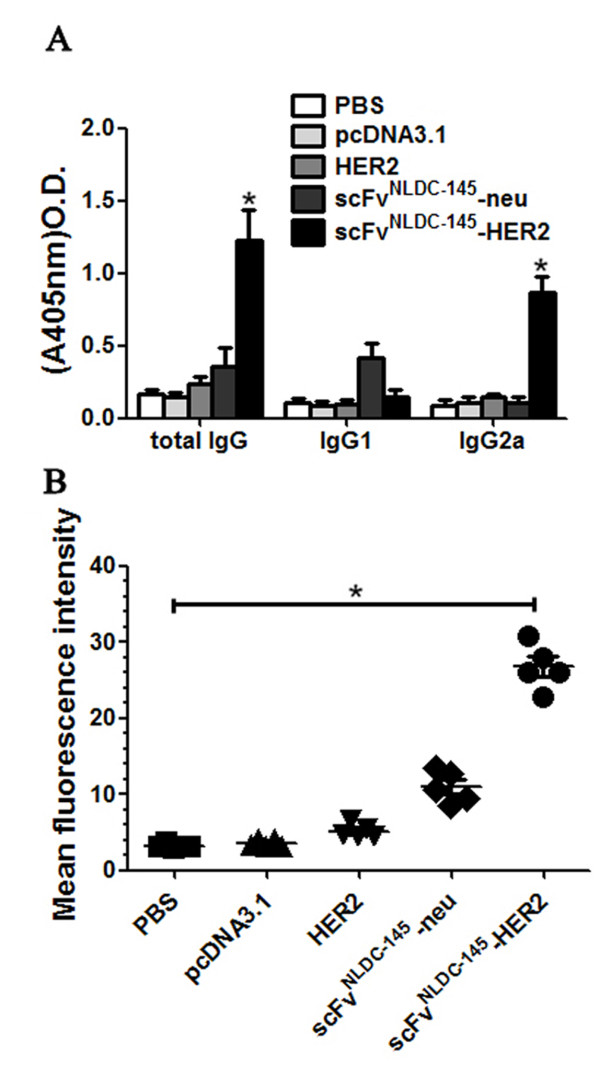
Vaccination with scFvNLDC-145-HER2 induced HER2-specific antibodies. BALB/c mice were vaccinated with HER2, scFvNLDC-145-neu or scFvNLDC-145-HER2. Control animals received PBS or pcDNA3.1. Sera were collected from the vaccinated animals after two vaccinations. A HER2-specific total IgG and IgG subclass (IgG1and IgG2a) antibodies in sera from the vaccinated animals after 1:100 dilution were determined by ELISA. The mean OD405 values of pooled sera from each group (5 mice per group) were presented. Bars, SE. The background OD405 of normal mouse sera was < 0.04. B D2F2/E2 cells were incubated with the immune sera obtained from the vaccinated animals, and surface bound antibodies were detected using FITC-labeled secondary antibodies. Samples were then analyzed by flow cytometry. The data were represented as mean fluorescence intensity. Normal mouse sera served as control. All results were representative of two independent experiments. *, P < 0.01, scFvNLDC-145-HER2 compared with other groups.